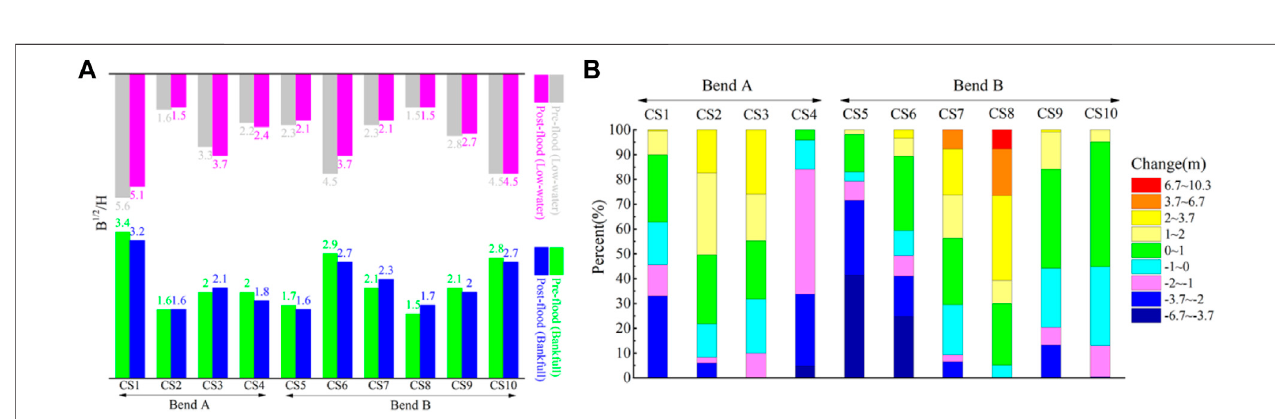
FIGURE 11 | (A) Variations of width to depth ratio (B 1/2 /H) for the bankfull channel and low- fl ow channel during fl ood season in 2016. (B) The range proportion of erosion and deposition on the convex bank of Bend A and Bend B during fl ood season in 2016.